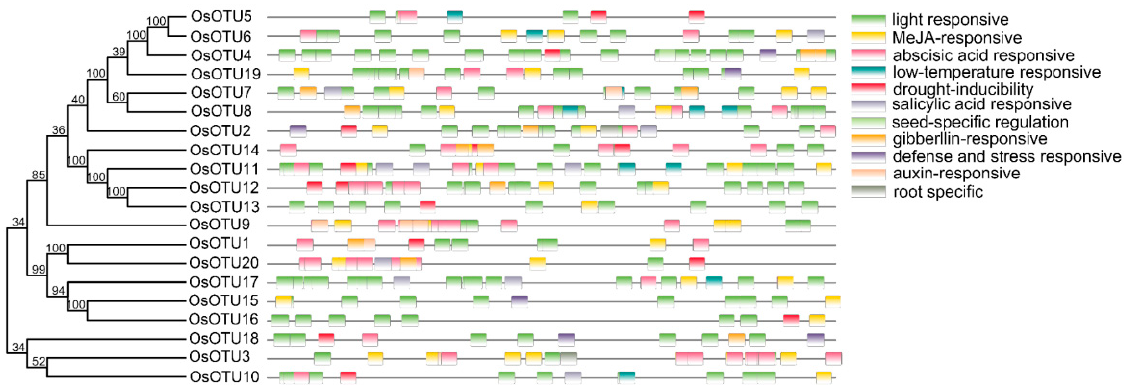
Figure 4. Prediction and analysis of OsOTU gene cis -acting elements. The potential cis -regulatory elements in the promoter regions 2000 bp upstream of the Oryza sativa were predicted by the PlantCARE website. Different colors indicated the elements related to growth and development (seed-specific regulation and root-specific), plant hormones (methyl jasmonate, abscisic acid, salicylic acid, gibberllin acid and auxin), and stress responsiveness (light, low temperature, and drought inducibility, defense and stress responsive).